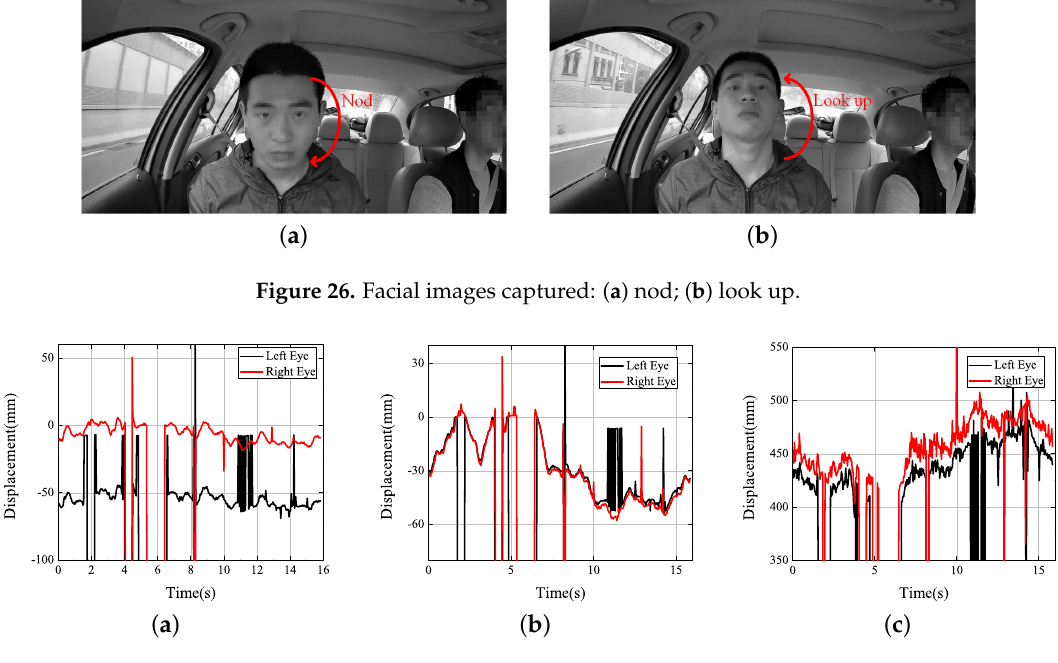
Figure 27. Experimental results obtained (fatigue study): ( a ) X axis; ( b ) Y axis; ( c ) Z